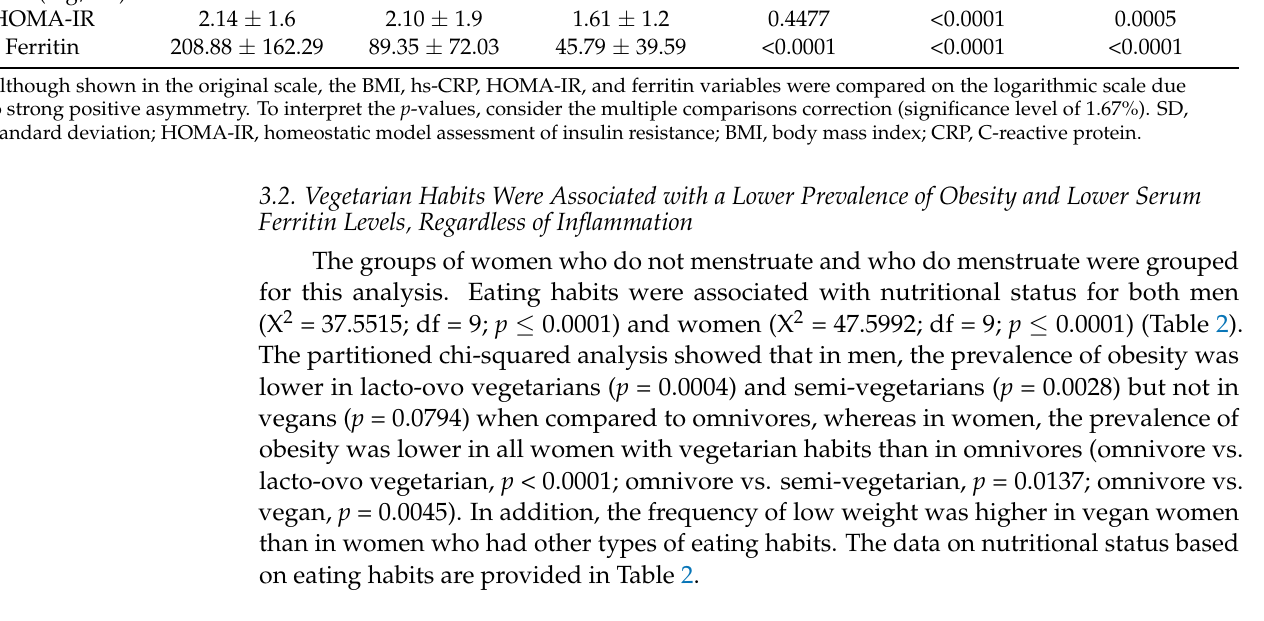
Table 2. Distribution of nutritional status based on eating